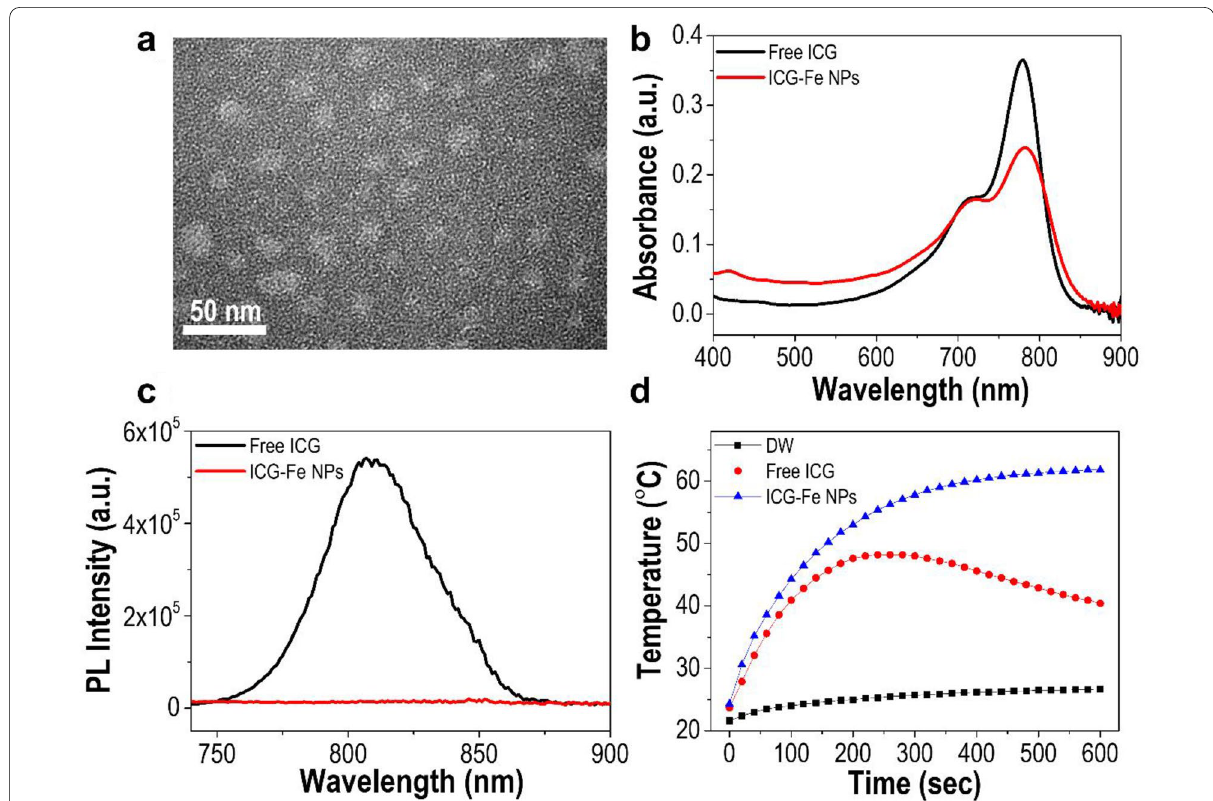
Fig. 3 Characterization of ICG‑Fe NPs. a TEM image. b UV/Vis absorption spectra and c fluorescence emission spectra of free ICG (black line) and ICG‑Fe NPs (red line) in water. d Photothermal heating curve of pure water, free ICG, and ICG‑Fe NPs over 10 min of laser irradiation (785 nm, 1 W). All experiments were conducted at the same concentration based on the ICG